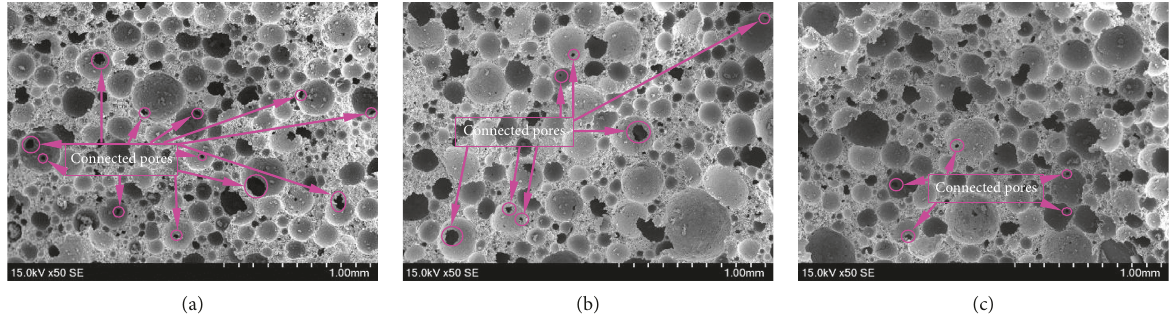
Figure 10: SEM images of the foam concrete. (a) SEM image of 800-C. (b) SEM image of 800-F2. (c) SEM image of